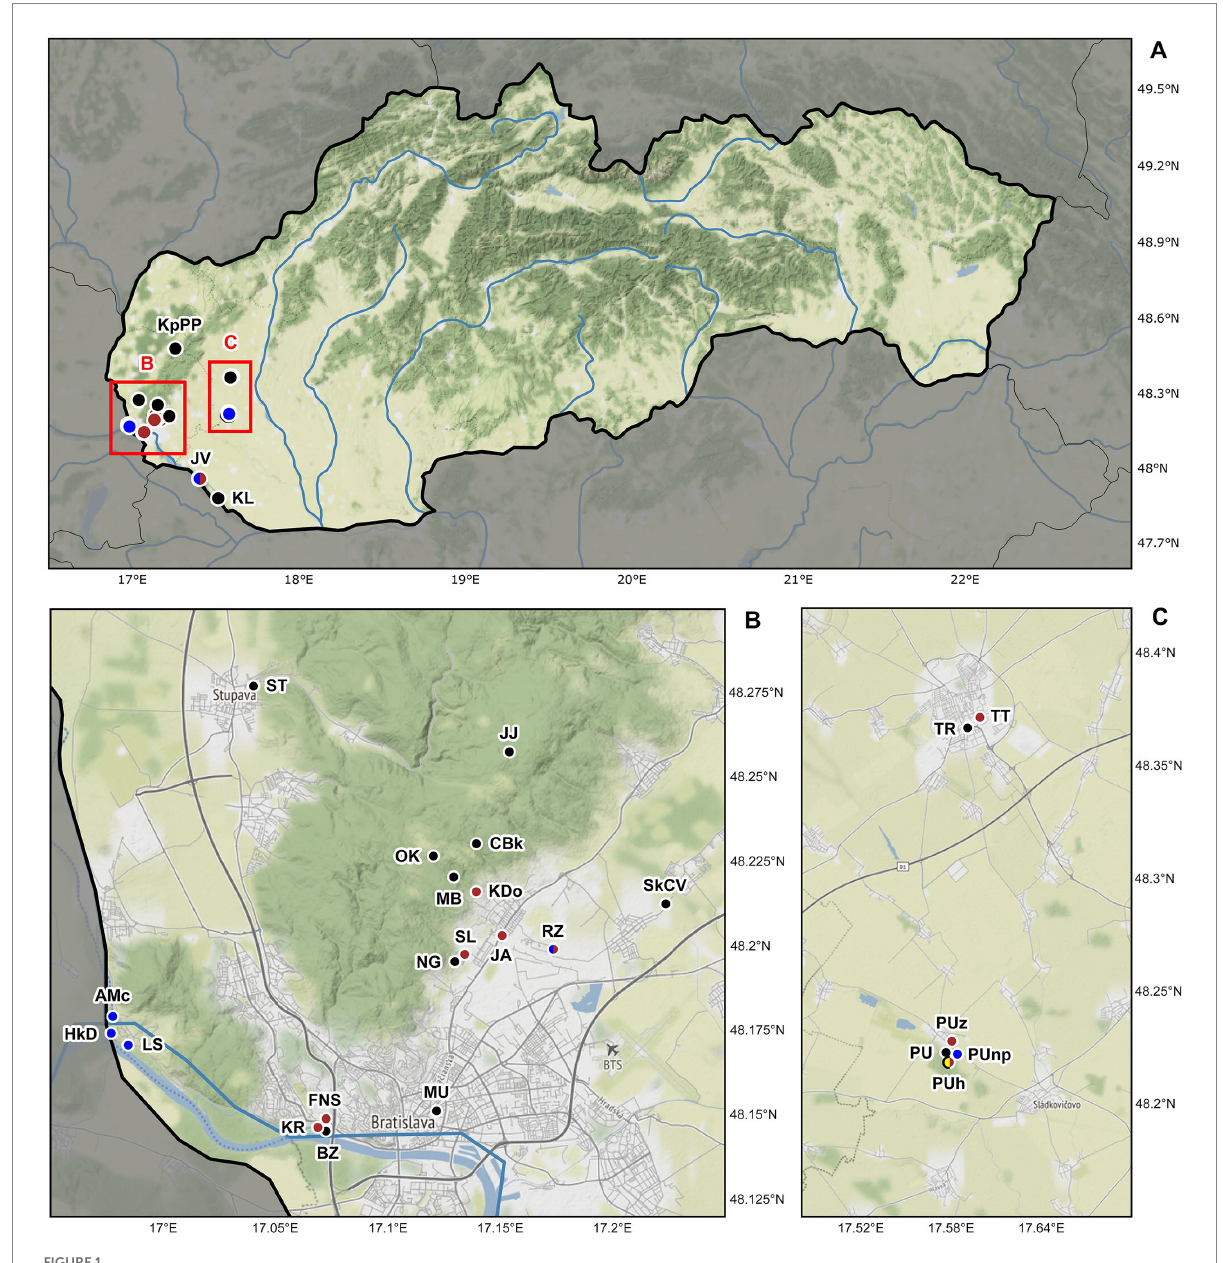
FIGURE 1 Sampling sites of lumbricid earthworms examined for the presence of plagiotomids in Slovakia, Central Europe. (A) Map of Slovakia. Details of two studied areas B and C (marked by red rectangles) are depicted below the map of Slovakia. (B) Detail of the Bratislava district showing the localization of 18 sampling sites. (C) Detail of the Trnava and Galanta districts showing the localization of six sampling sites. Black dots denote localities where plagiotomids were not recorded, while brown dots denote localities where plagiotomids were isolated from anecic earthworms, yellow dots denote those from epigeic earthworms, and blue dots those from endogeic earthworms. For locality codes, see Supplementary Table S1. Map tiles by ©Stamen Design, under a Creative Commons Attribution (CC BY 3.0) license. Data by OpenStreetMap, under